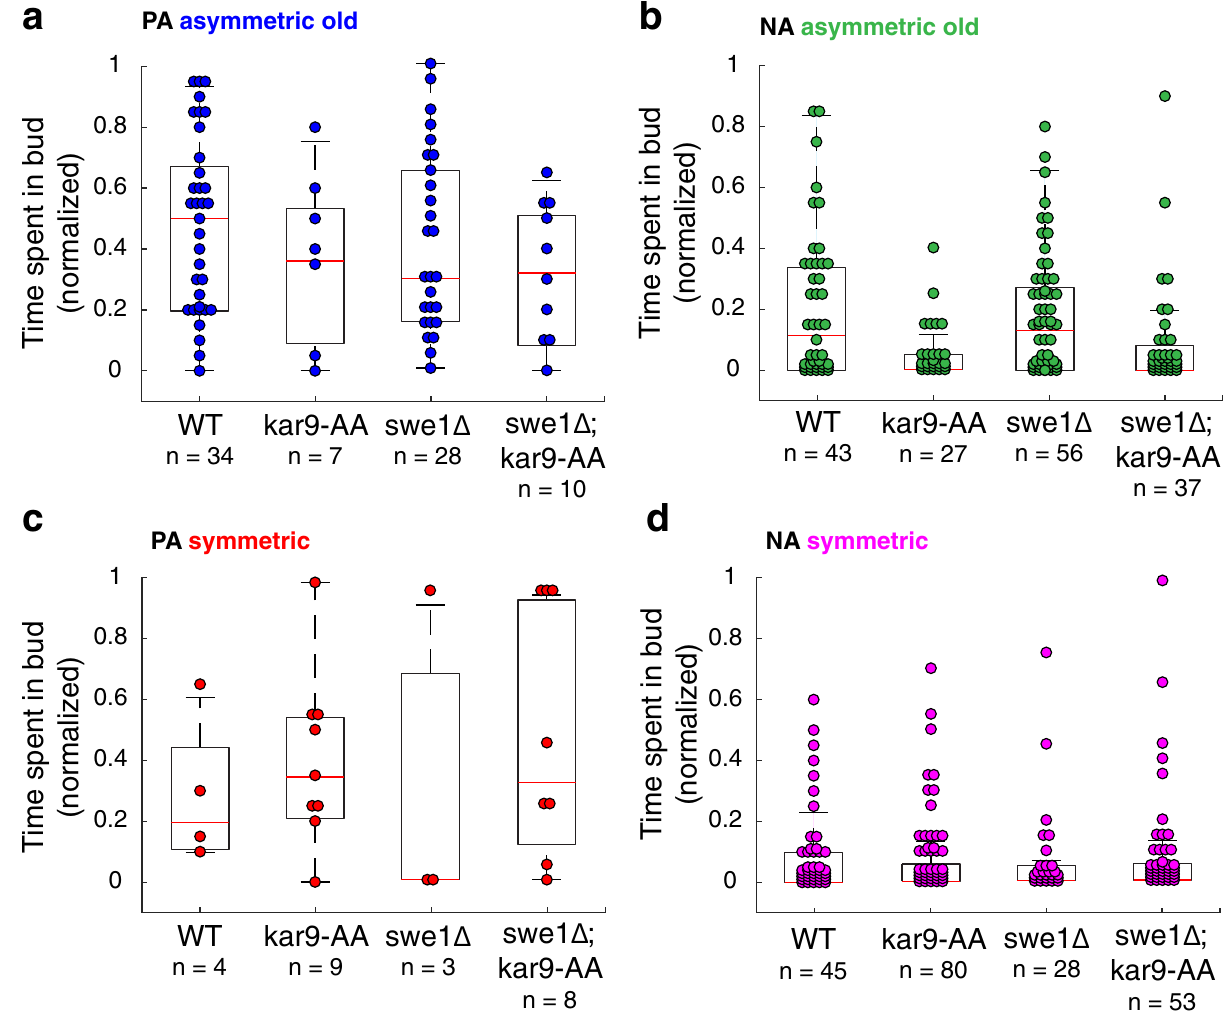
Figure 5. Spindle alignment is correlated with Kar9 residence time in the bud. Number of time points spent in bud normalized to length of the acquisition for ( a ) PA-asymmetric spindles, ( b ) NA-asymmetric spindles, ( c ) PA-symmetric spindles and ( d ) NA-symmetric spindle. In PA-asymmetric spindles, Kar9 spends more time in the bud than NA-asymmetric spindles or PA and NA symmetric spindles. For both PA and NA-asymmetric spindles, the kar9-AA and swe1∆ mutations reduce Kar9 residence time in the